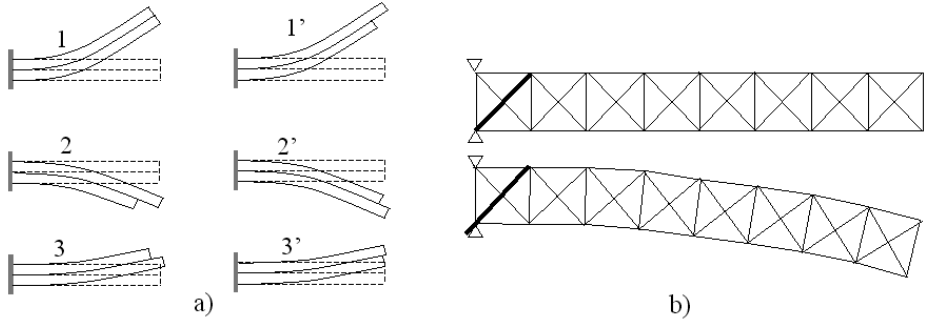
Fig. 8. PAR strategy for a cantilever